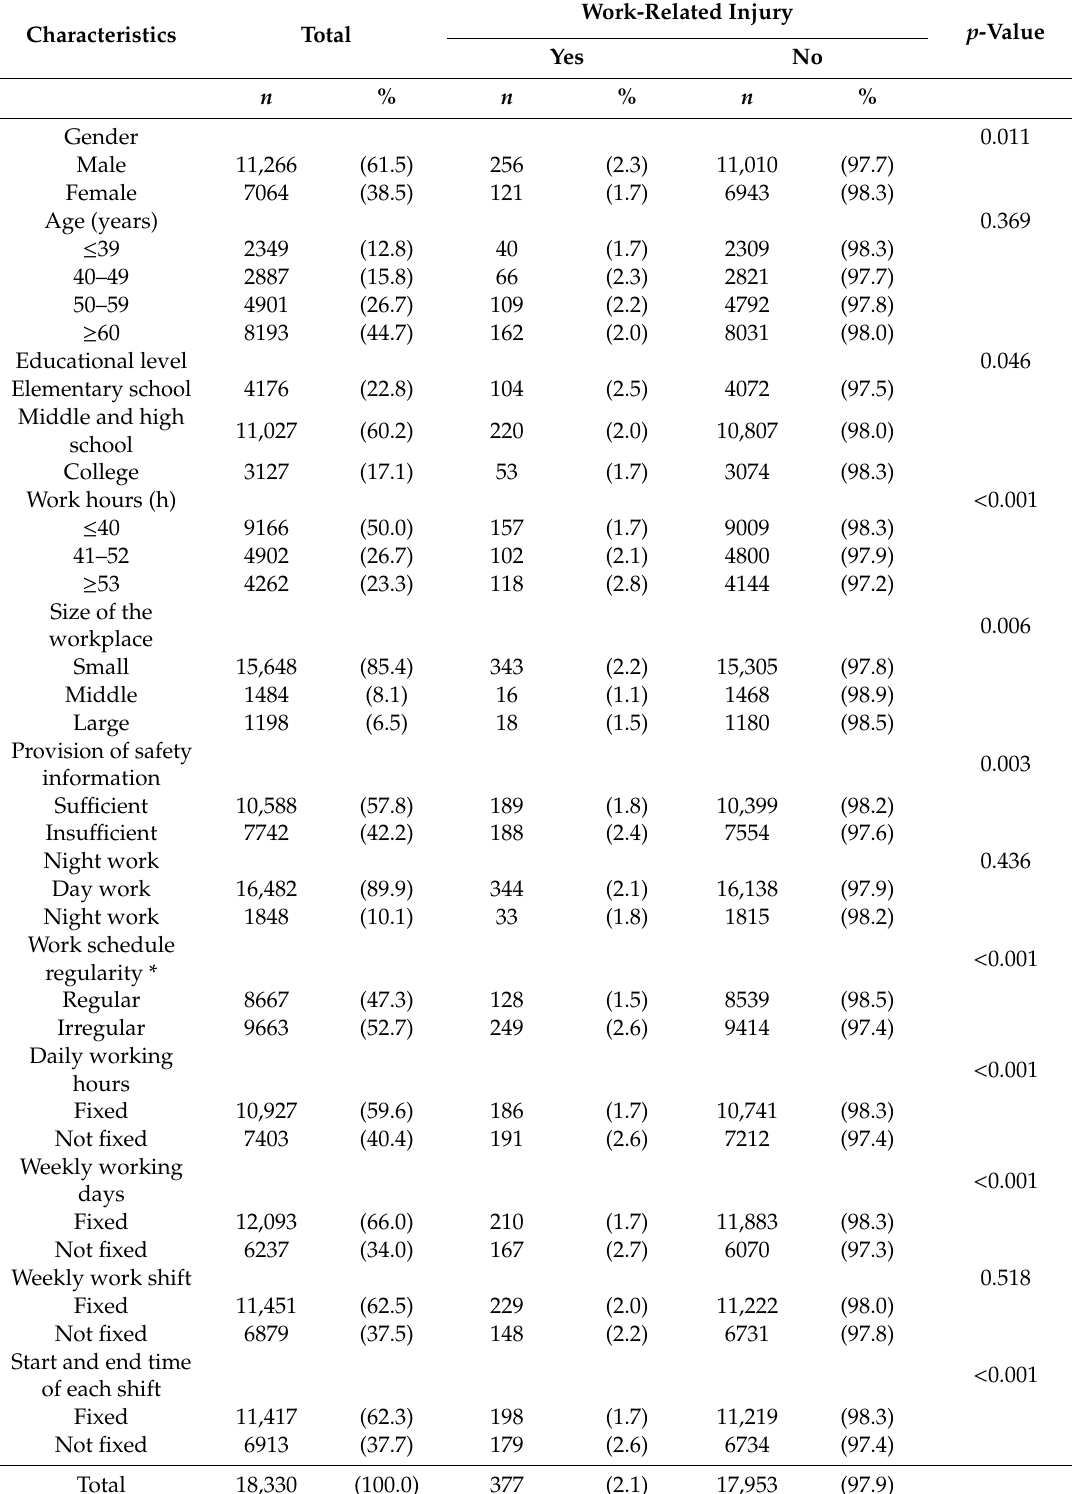
Table 1. General characteristics of the study population and the status of work-related injury according to individual and occupational